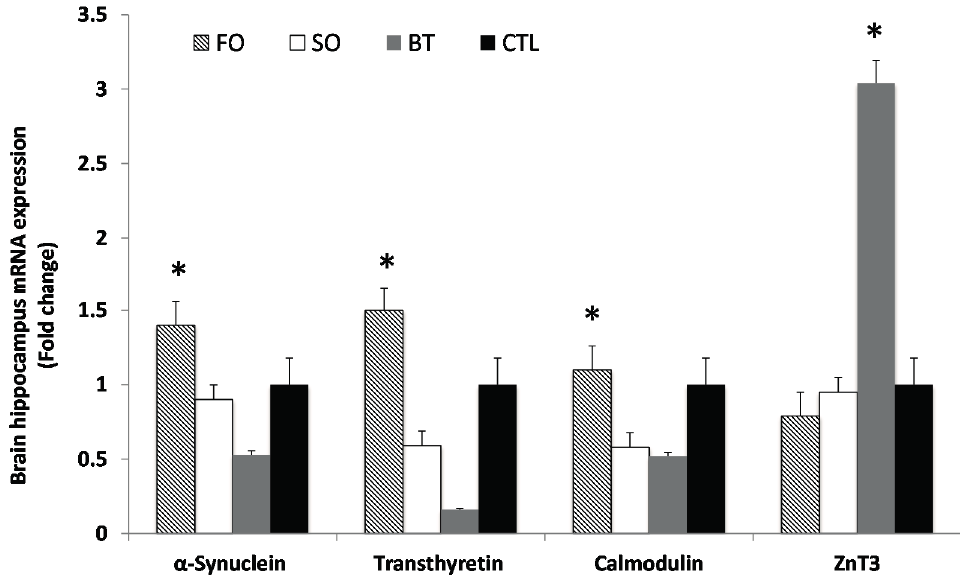
Figure 1. Expression of α -synuclein, transthyretin, calmodulin and ZnT3 in the brain hippocampus of treatment groups compared to the CTL group. Results are normalized to the expression of GAPDH and β -actin. Treated samples were expressed relative to gene expression of the CTL group. Statistical analysis was performed using the Student’s t -test. Values indicated by * show significant differences compared with the CTL group at p < 0.05. FO, fish oil; SO, soybean oil; BT, butter; CTL, control. Table 1. Fatty acid profile (% of total identified fatty acids) of the brain hippocampus. Treatments FO SO BT CTRL SEM C16:0 (Palmitic acid) 32.43